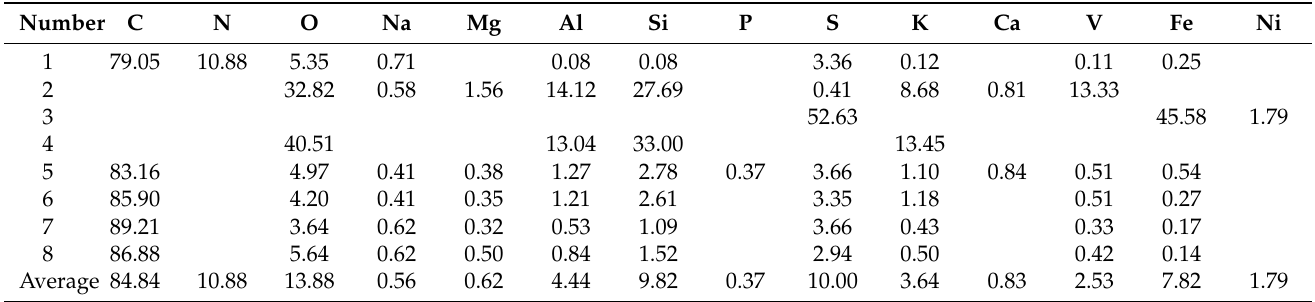
Table 5. Spectral microdomain composition analysis of vanadium mica and carbonaceous clay minerals at positions 1–8 in Figure 6a.